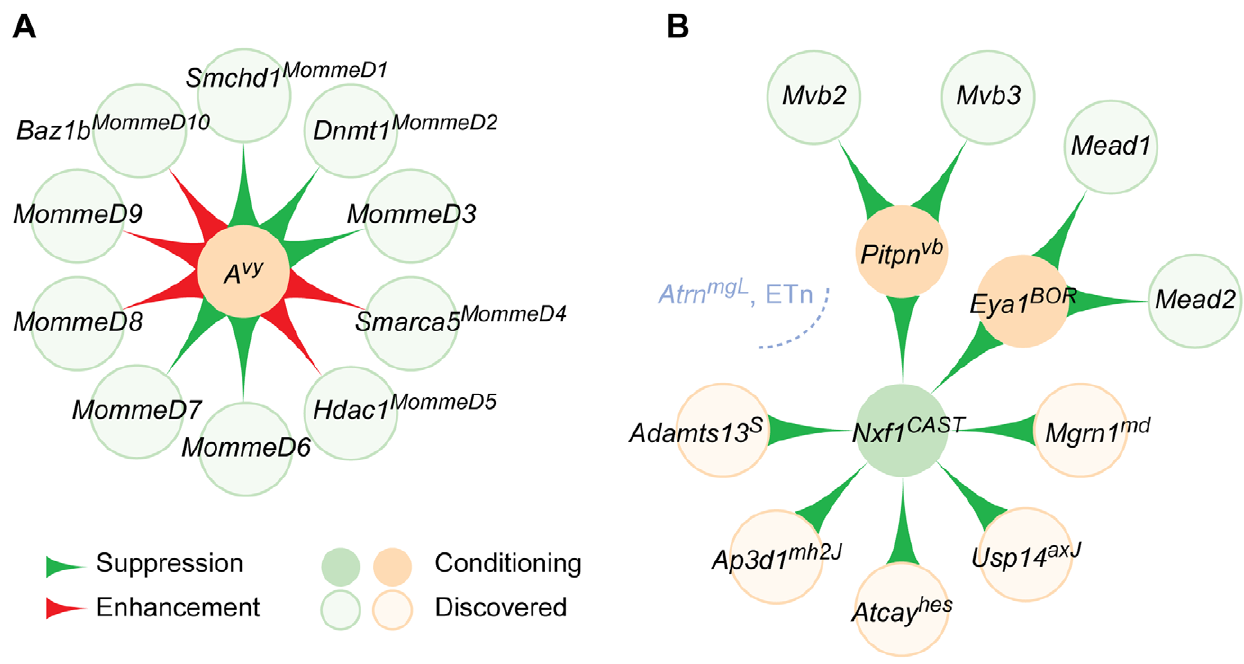
Figure 2. Modifier gene networks have directional edges between nodes. Mouse modifier gene interactions can be diagrammed as nascent modules of an interaction network. (A) Identification of multiple modifier genes for a conditioning mutation through either mutagenesis or linkage analysis of strain variants can be represented as in ‘‘outside-in’’ network module, where one node (the conditioning mutation, beige circle) is a sink hub, acted on by each experimentally discovered modifier (light green circles). MommeD modifiers of the epigenetically sensitive A vy mutation are illustrated as an example. Direction of effect is indicated by the flared edges (connections) between nodes. (B) Validation of modifier mechanisms across independent mutations result in an ‘‘inside-out’’ module, with the shared modifier (green circle) acting as a source hub on several conditioning or test mutations. An incipient network around Nxf1 Mvb1 , based on shared genetic mechanism, is illustrated. Atrn mgL and several intronic ETn-induced mutations are not affected by Nxf1 Mvb1 variation (gray). Pitpna vb and Eya1 BOR have additional known modifiers (light green), adding modules to the incipient network.